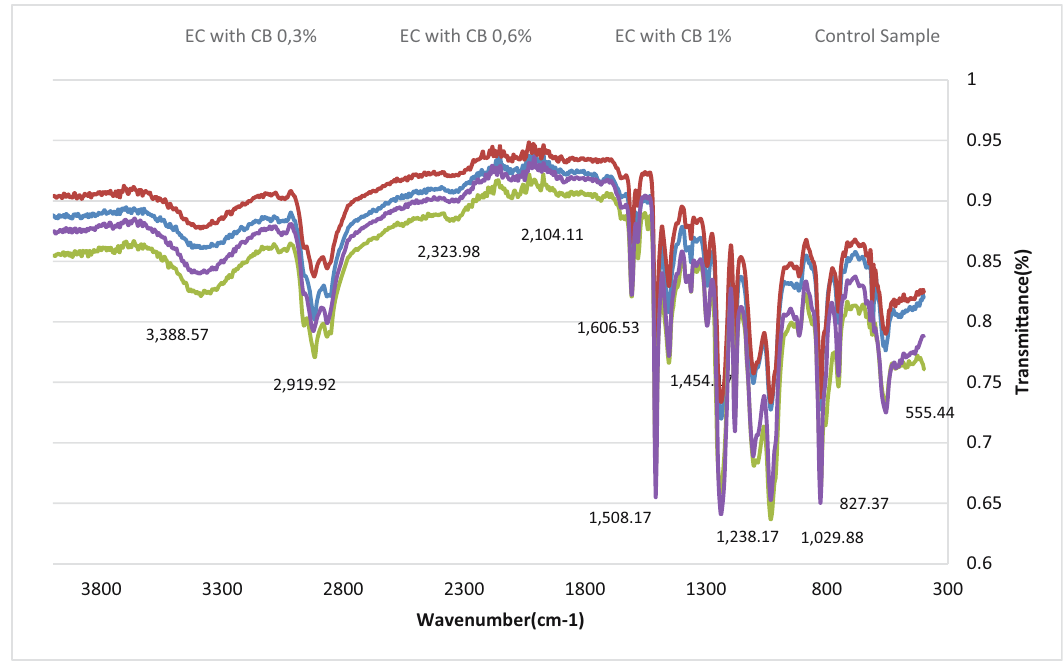
Figure 7: FT - IR results of neat ( control sample ) and 0.3, 0.6, and 1 wt% carbon black added samples.